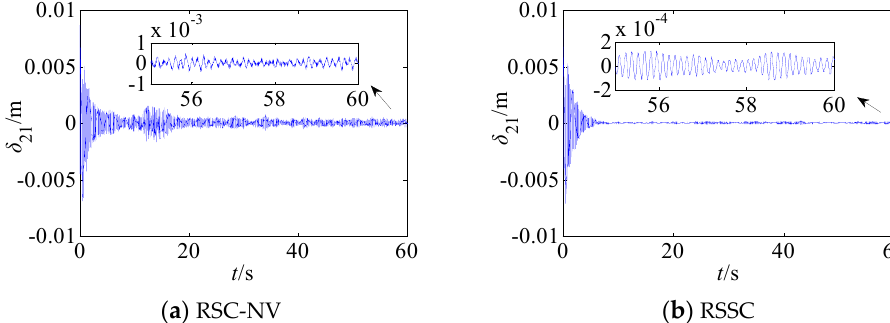
Figure 10. The first mode coordinates of the flexible link